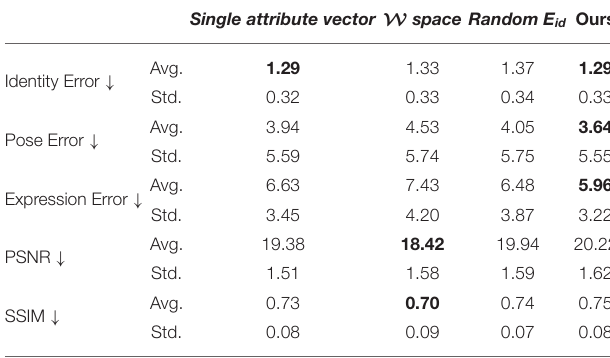
FIGURE 4 | Qualitative ablation study on different variants. Our original model performs better than others. TABLE 3 | Quantitative ablation study on different variants for face